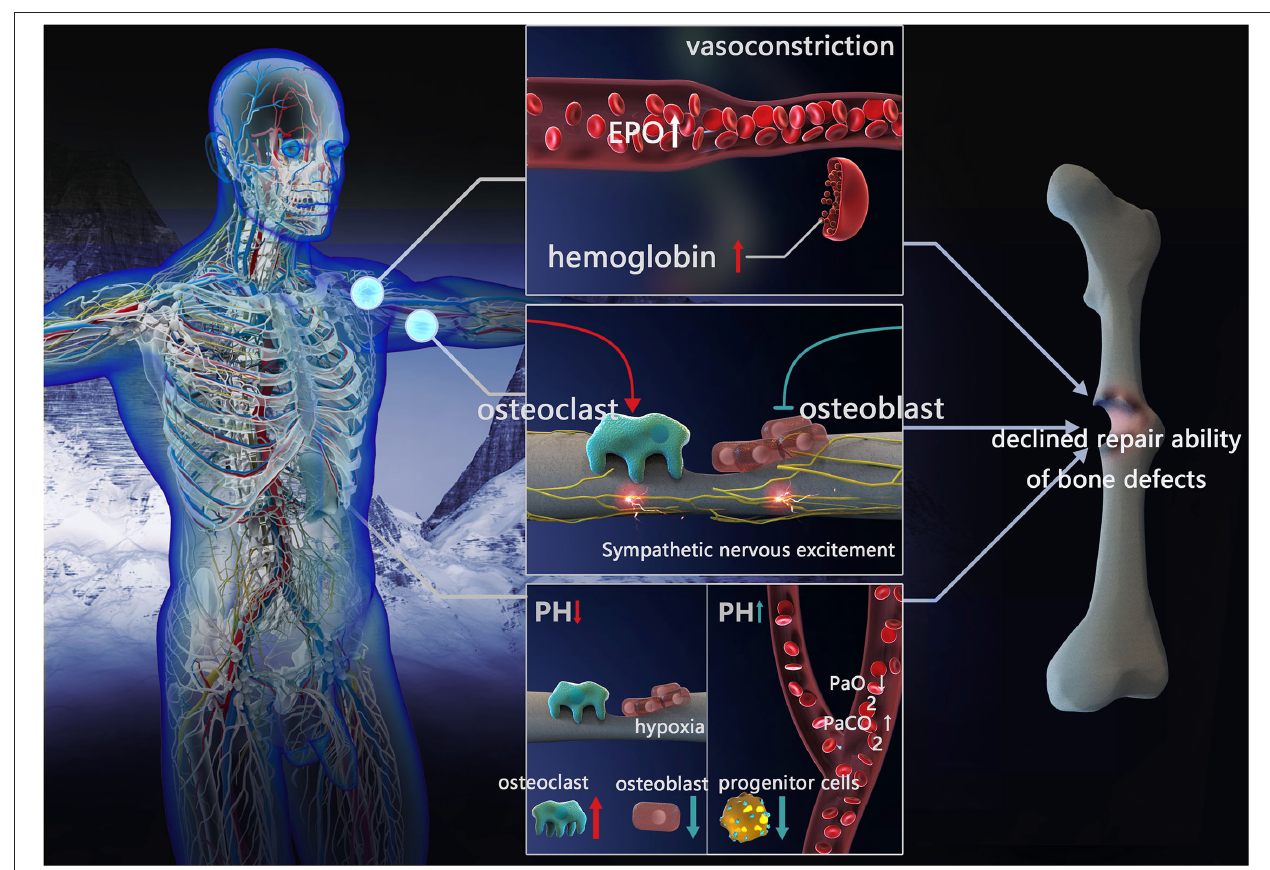
FIGURE 1 | Factors influencing repair of bone defects in high-altitude environment. Blood compensation: vessels constrict, EPO concentration and hemoglobin increased. Sympathetic nervous excitement: inhibit osteoblast activity and promote osteoclast formation. Acid-base compensation: In local acid-base compensation, decreased pH impeding osteoblasts differentiation and enhanced osteoclast activation. In systemic acid-base compensation, with the decreasing of PaO 2 and increasing of PaCO 2 , increased pH inhibits bone marrow progenitor cell proliferation (EPO, erythropoietin; PaCO 2 , partial pressure of arterial CO 2 ; PaO 2 , partial pressure of